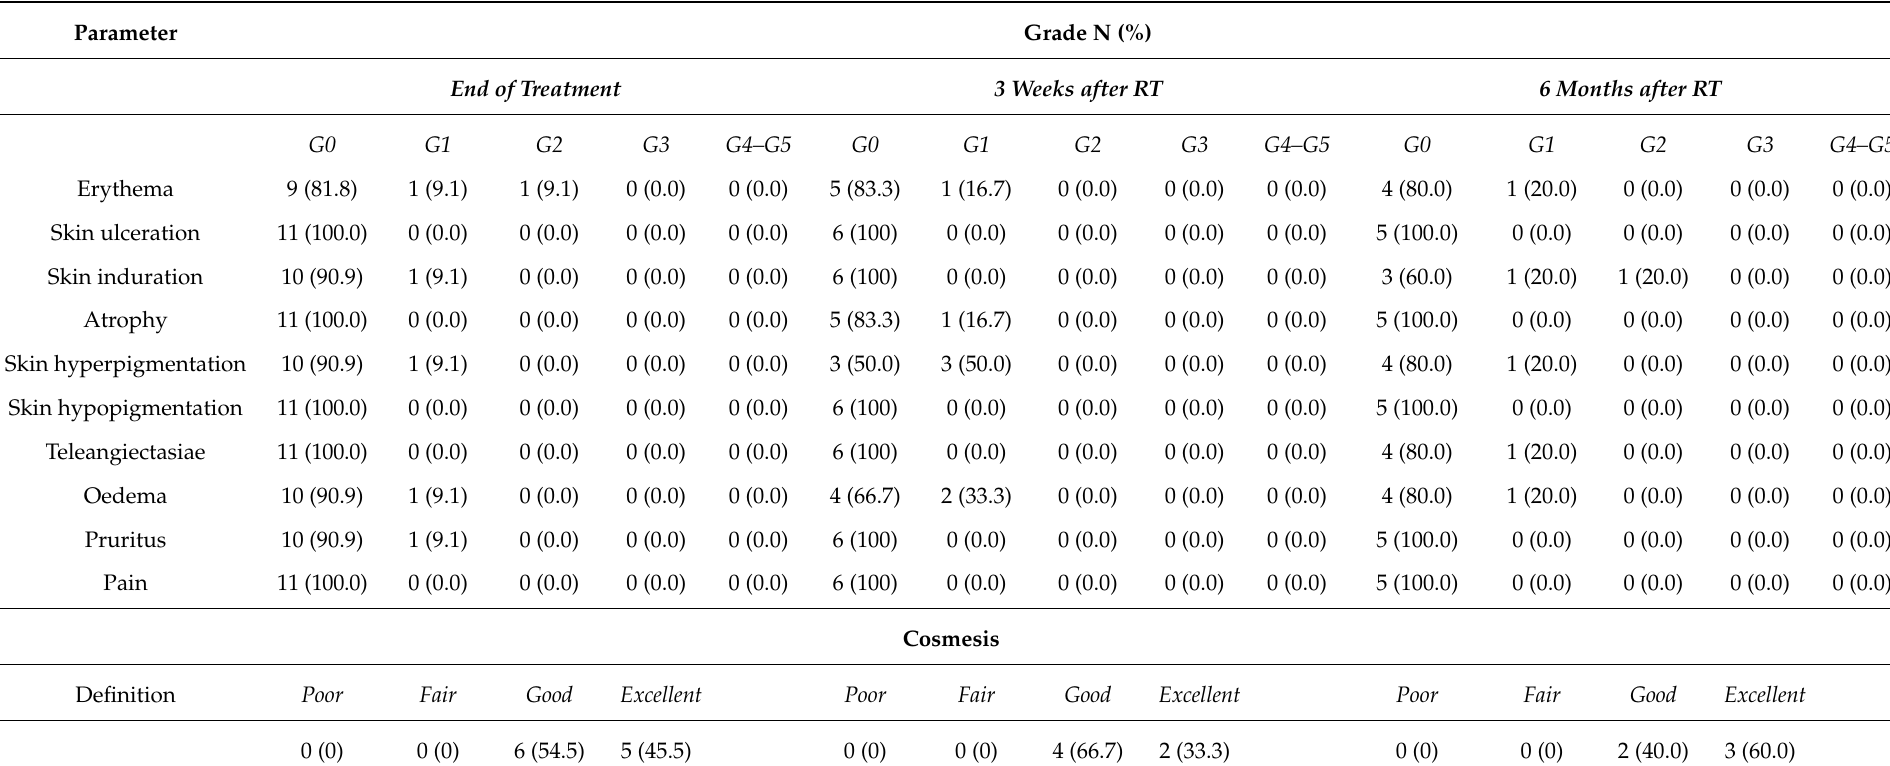
Table 6. Toxicity profile and cosmesis for the 28.5 Gy in 5 fractions over 5 weeks